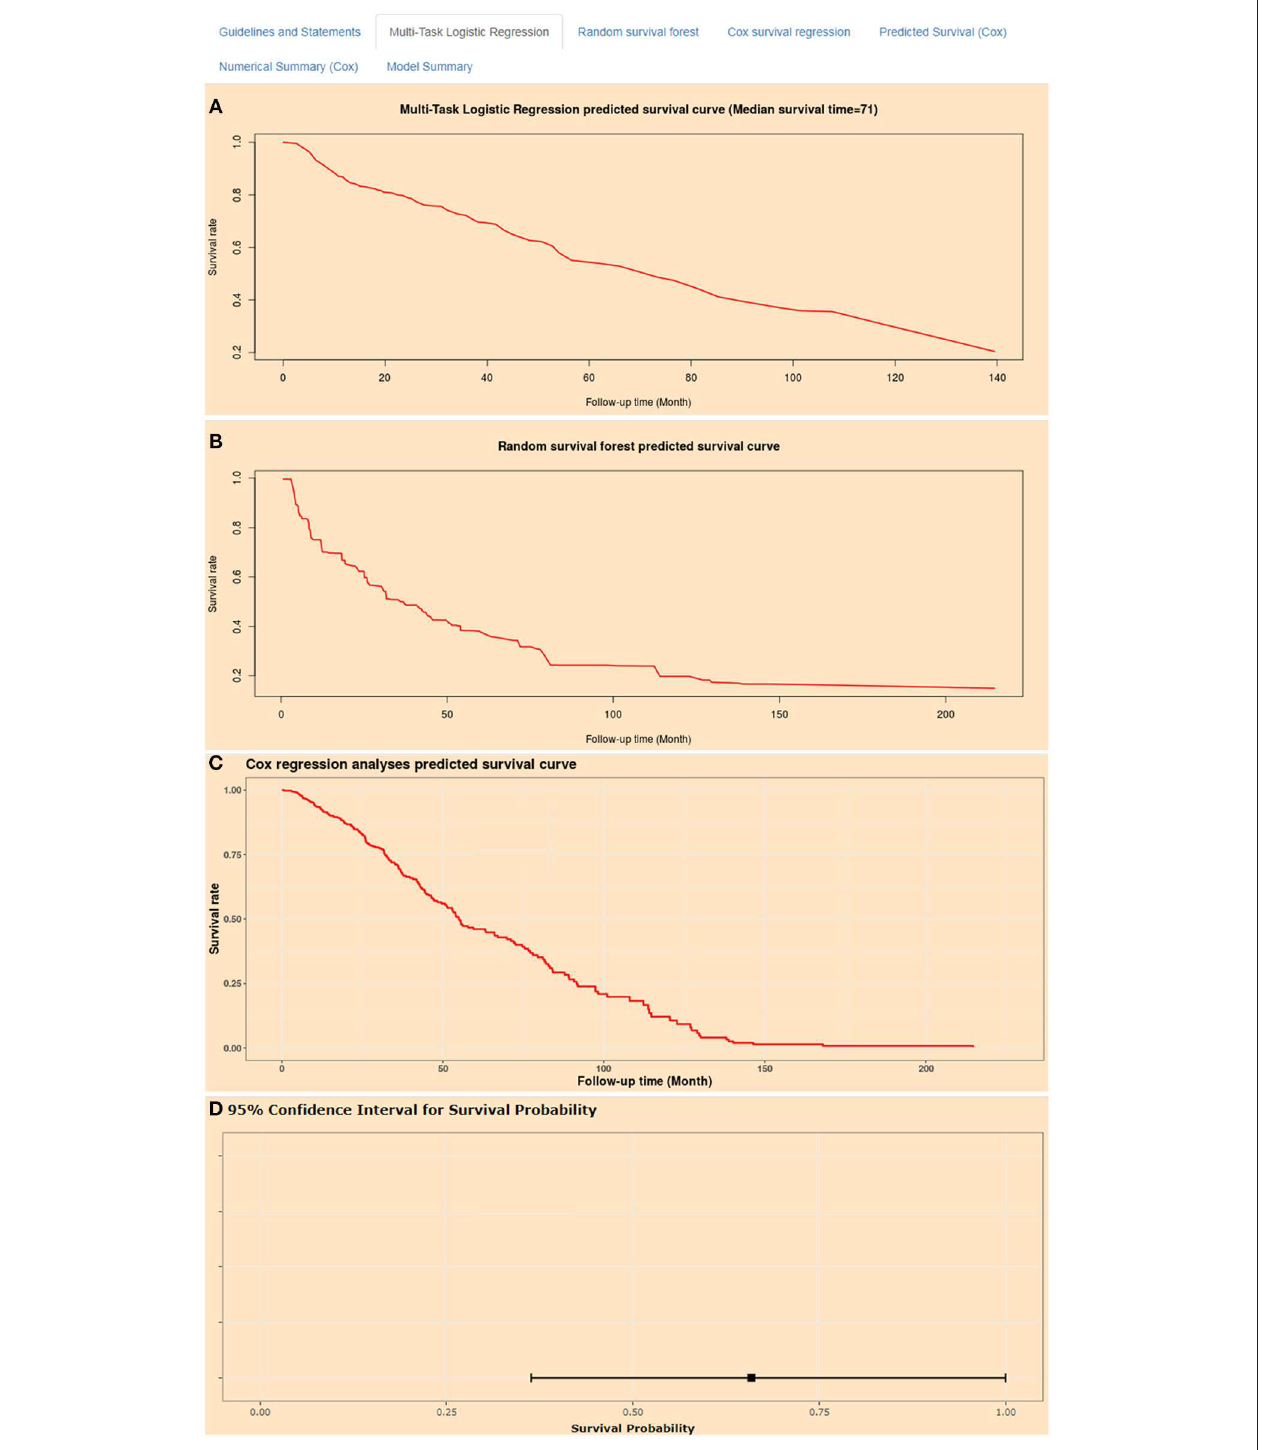
FIGURE 8 | Home page of Smart Cancer Survival Predictive Predictive System. (A) Multi-Task logistic regression predicted survival curves. (B) Random survival forest predicted survival curves. (C) Cox survival regression predicted survival curves. (D) Cox survival regression predicted mortality percentage and 95% confidence